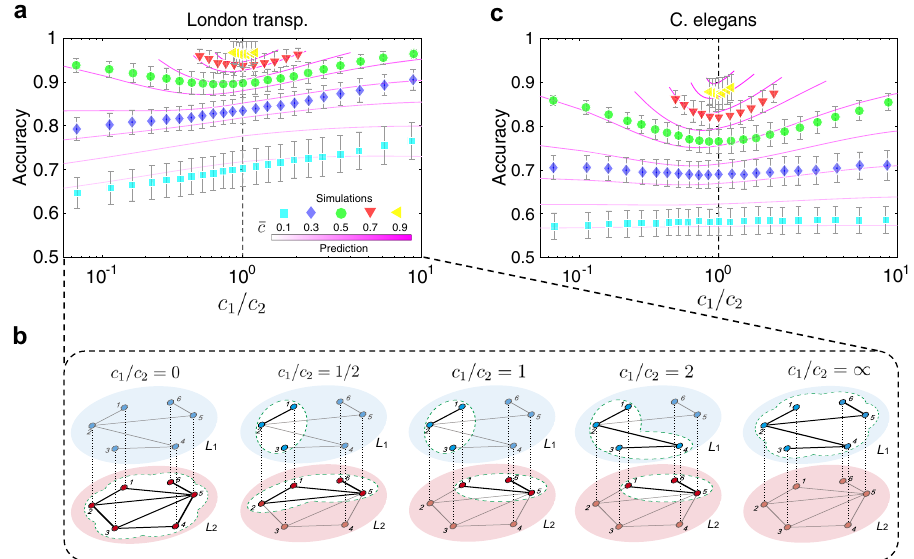
Fig. 5 Allocating budget for reconstruction. a The accuracy of reconstruction as a function of c 1 / c 2 from 0 to ∞ for the London transportation multiplex network, where c 1 and c 2 indicate the fractions of partial observations in layer 1 and layer 2, respectively. The colored symbols indicates the simulation results corresponding to different budgets (cid:1) c , while the magenta lines are the predictive results based on the discrimination indicator. b Different strategies to allocate limited budget are illustrated in fi ve toy multiplex networks, where the dashed white area is the partial observations of multiplex networks. c The accuracy of reconstruction as a function of c 1 / c 2 from 0 to ∞ , when given total budget (cid:1) c for the C. elegans multiplex connectome. The error bar indicates standard deviation in this fi